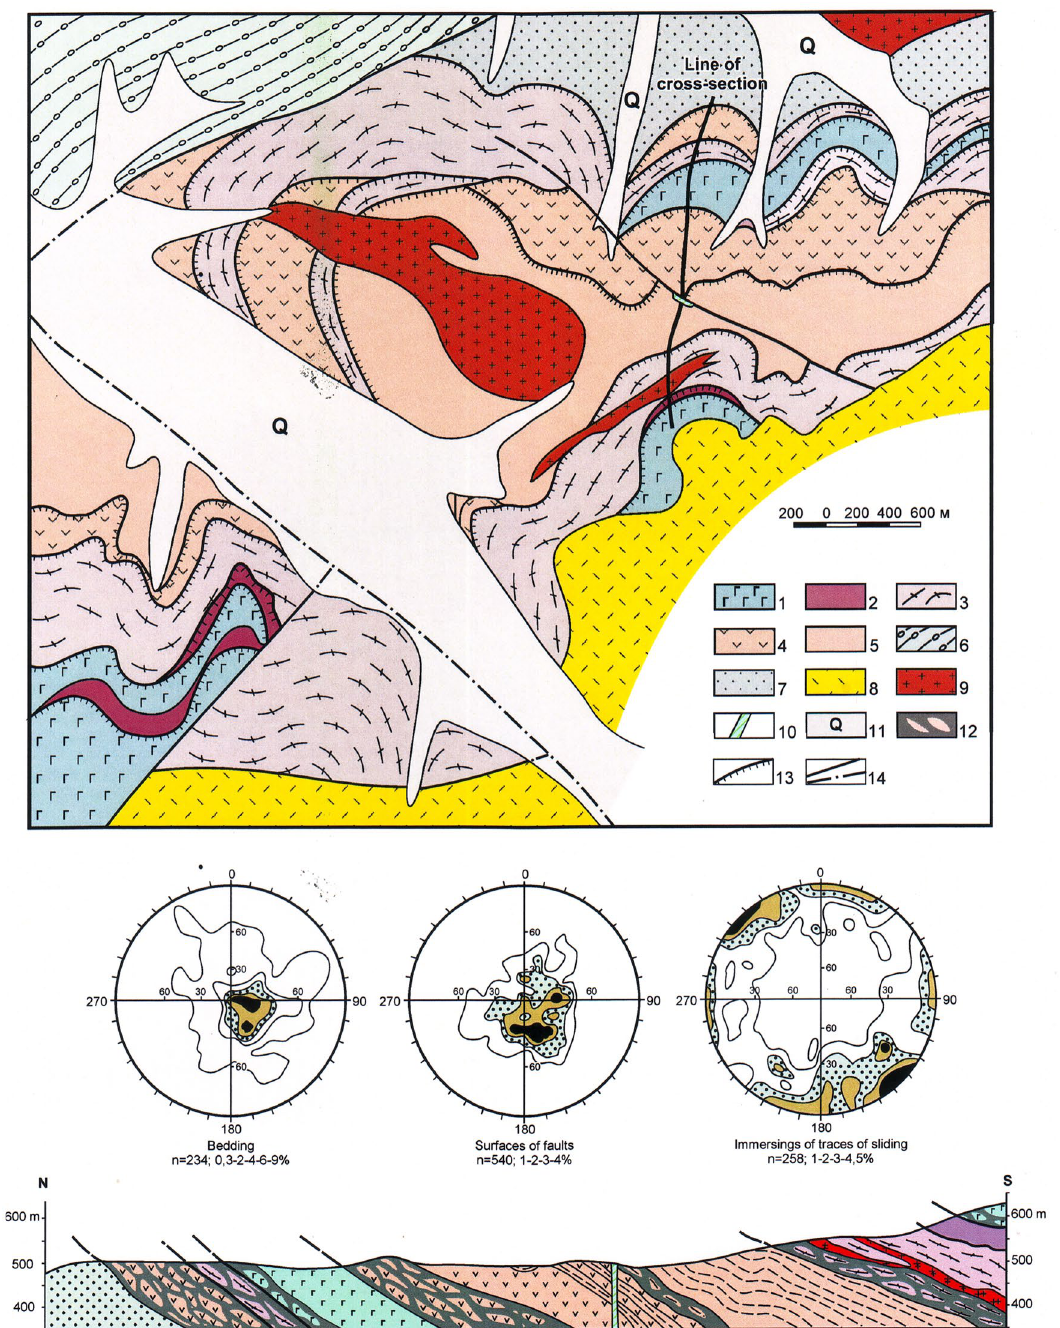
Figure 6. The bottom part of Sebuchar complex in the near-axial portion of the Chuguyevka synform. Modified after [ 27 , fig. 14]. Location see in the Fig. 3. 1–5 – Sebuchar complex: 1 – gabbroid, 2 – serpentinized pyroxenite, 3 – mica schist and amphibolite, 4 – basalt, 5 – siltstone; 6 – Ust’-Zhuravlevka complex: siltstone with inclusions and slices of the sandstone and chert; 7 – Udeka complex: sandstone with the interbeds of the siltstone; 8–10 – Late Cretaceous volcanics (8), granite (9) and diabase (10); 11 – Quaternary alluvium; 12 – mylonite zone; 13 – thrust; 14 – normal and strike-slip in the older age of the matrix and allochthonous bodies relative to the underlying Udeka, Ust-Zhuravlevka and Tudovaka rock complexes. The total thickness of the tectonostratigraphic sequence of this complex is at least 4000 m. Thus, it can be assumed that the fragments of the late Paleozoic seamounts, overlapping limestone caps and volcanic-terrigenous blocks from seamount slopes were accreted first during the formation of the Sebuchar